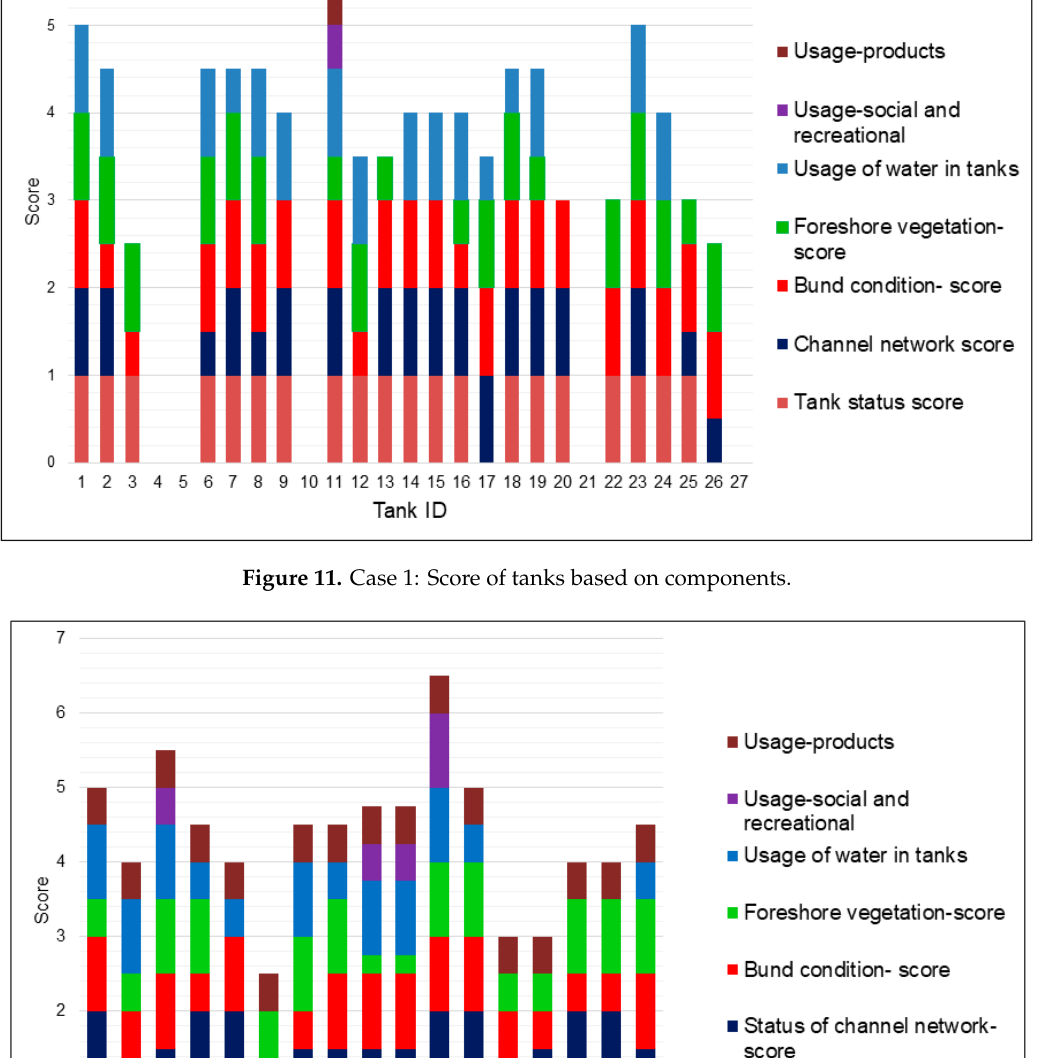
Figure 13. Relationship between change in agricultural land use and the status of the tank systems in case 1.